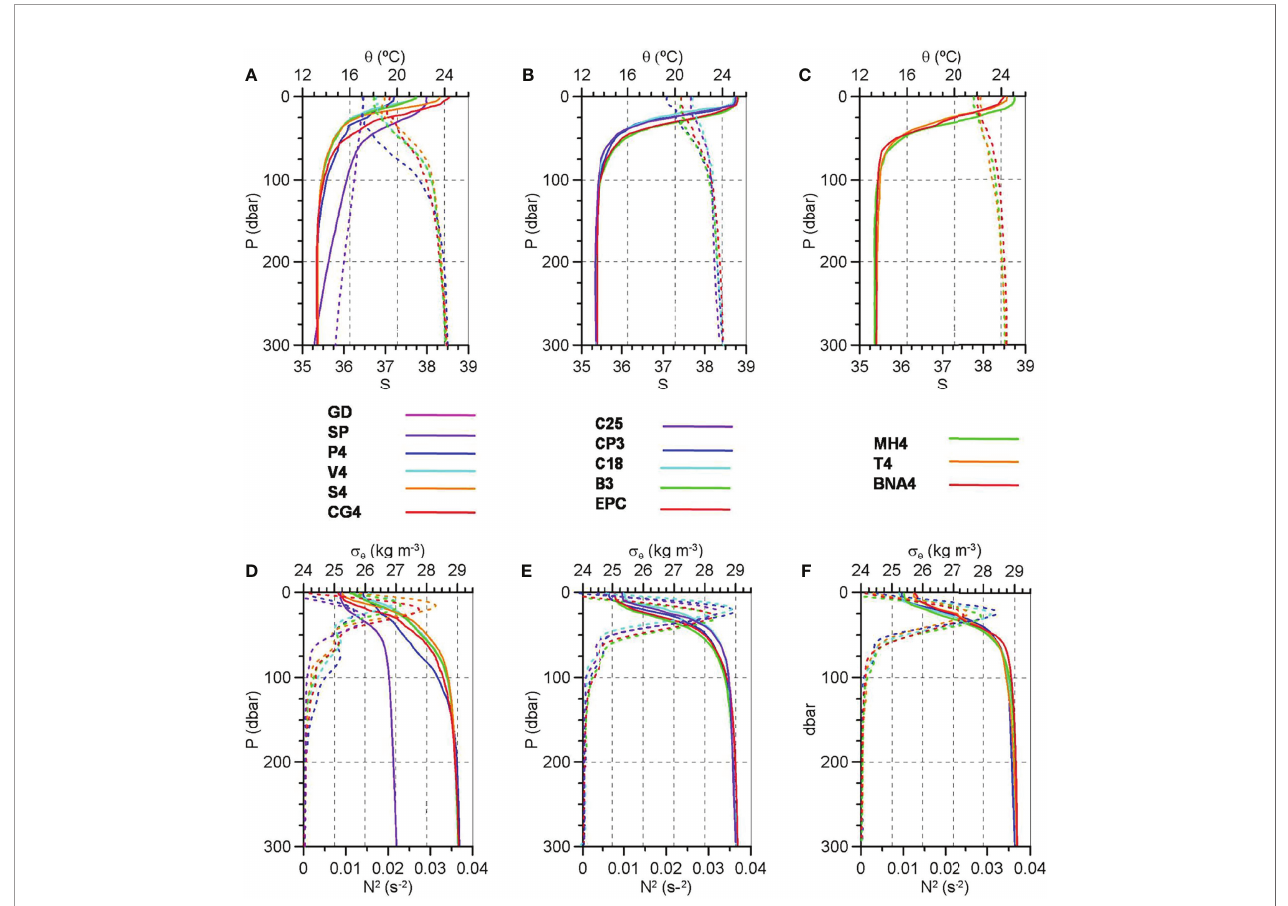
FIGURE 3 | Summer climatology computed for temperature (top panels, continuous lines), salinity (top panels, dashed lines), density (bottom panels, continuous lines), and N2 (bottom panels, dashed lines) vertical pro fi les at the selected oceanographic stations of the Gulf of Ca ́ diz and the Albora ́ n Sea (A , D) , Cape Palos and the south of the Balearic Islands (B , E) and those stations to the north of the Balearic Islands (C , F) . See color legend for station identi fi